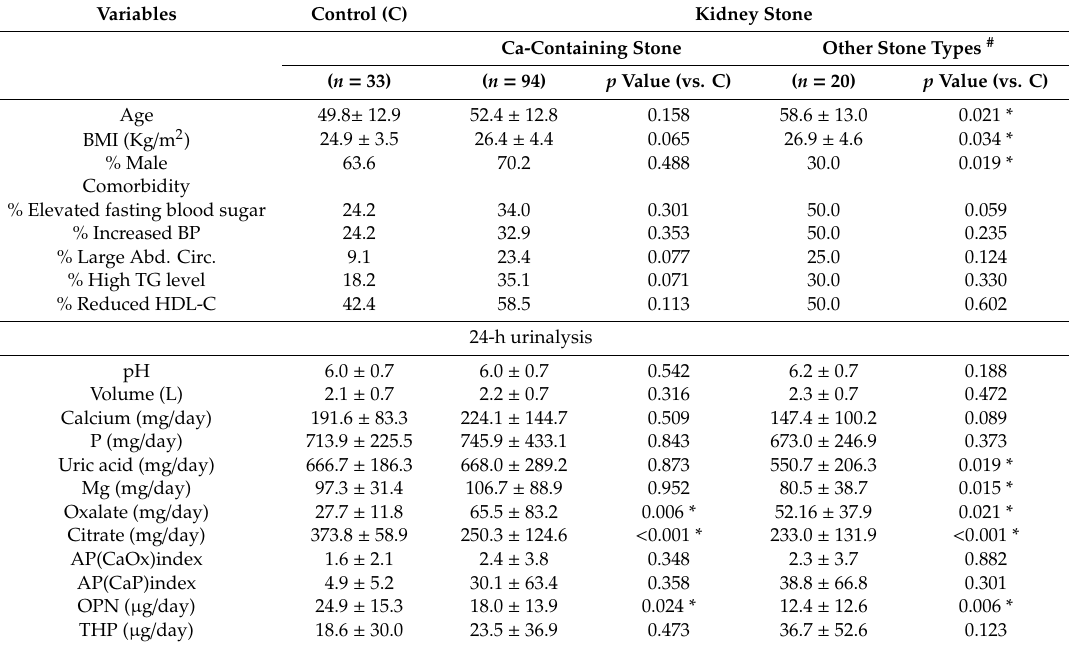
Table 1. Demographic data, 24-hour urinary chemicals, and stone composition in 147 patients. Data presented as mean ± SD. Variables Control (C) Kidney